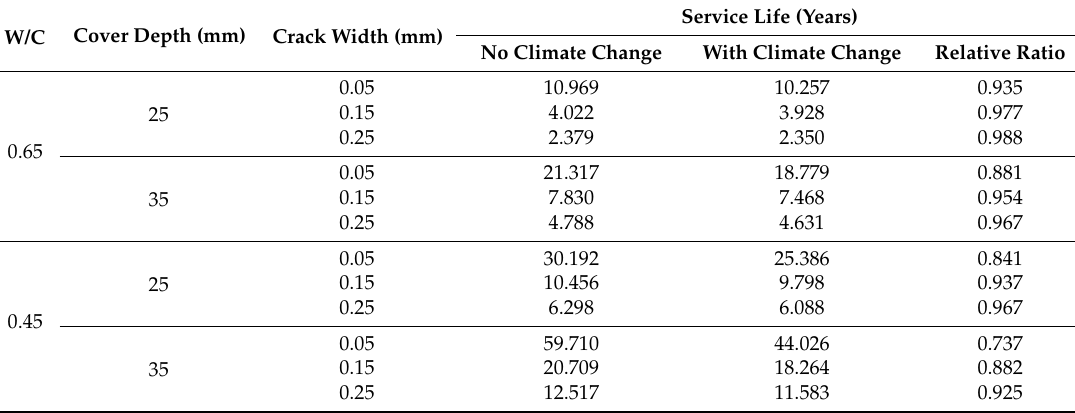
Table 8. Service life of cracked concrete-RCP 8.5, time slice